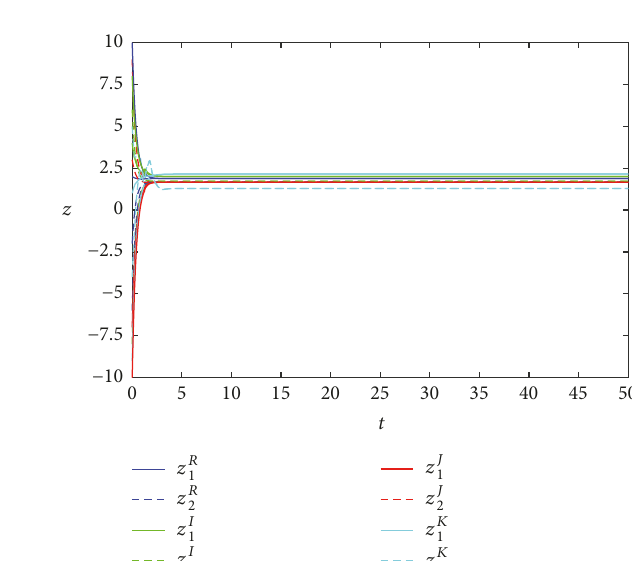
Figure 2: The states of four parts of 𝑦 1 and 𝑦 2 .